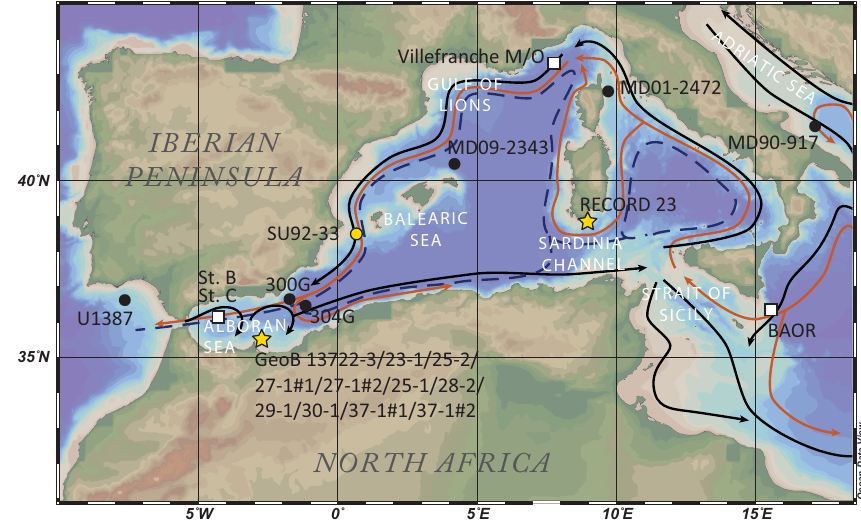
Figure 1. Map of the western Mediterranean Sea showing the locations of samples investigated in this study. Yellow dot indicates the sampling location of the sediment core from the Balearic Sea (SU92-33); yellow stars indicate the locations of the CWC-bearing cores from the Sardinia Channel (RECORD 23) and the southern Alboran Sea (for further details on the CWC from the Alboran Sea refer also to Fink et al., 2013). The cores discussed in this paper (Gulf of Cádiz: IODP site U1387, Balearic Sea: MD09-2343, northern Tyrrhenian Sea: MD01-2472, Adriatic Sea: MD90-917) are indicated by black dots, and seawater stations are marked by open squares. Arrows represent the main oceanographic currents. The black line shows the general trajectory of the Modified Atlantic Water (MAW) flowing at the surface from the Atlantic Ocean toward the western and eastern Mediterranean. The orange line represents the Levantine Intermediate Water (LIW) originating from the eastern basin. The black dashed line shows the trajectory of the western Mediterranean deep water (WMDW) flowing from the Gulf of Lions toward the Strait of